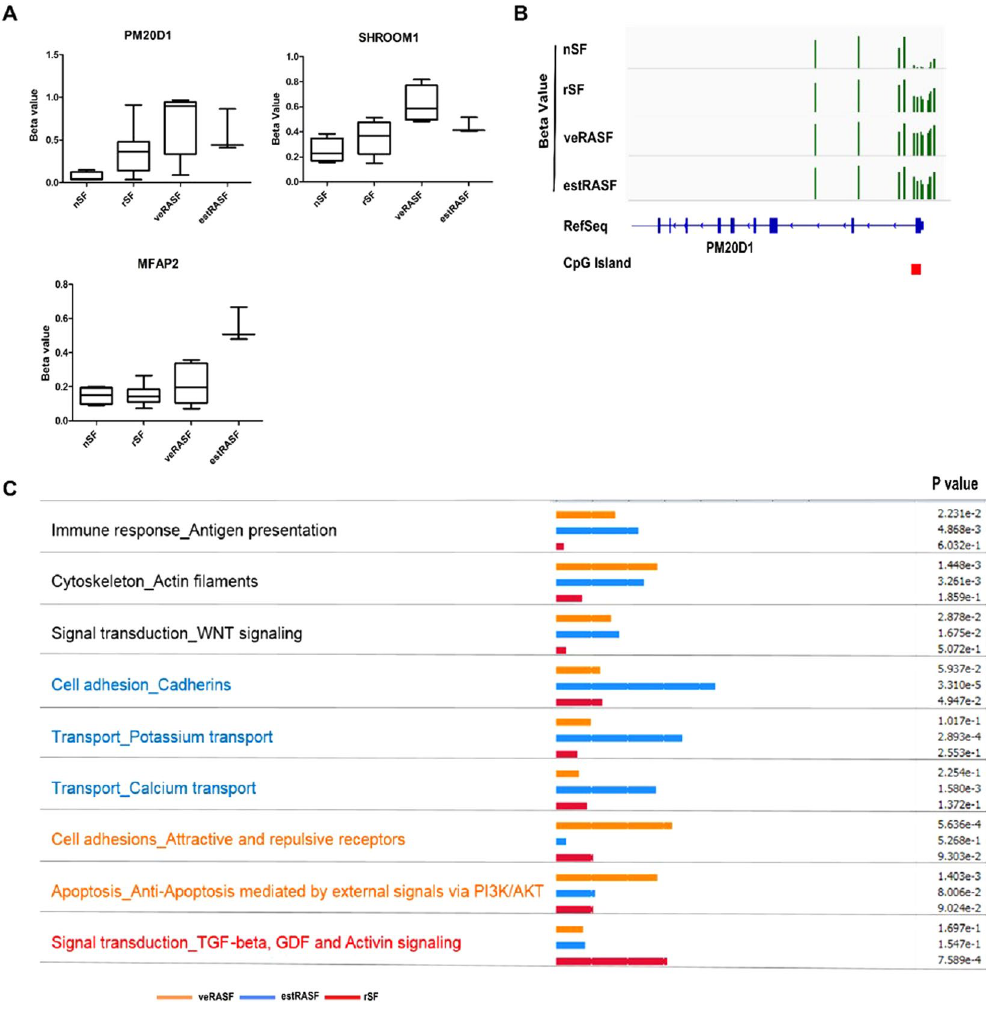
Figure 2. Hypermethylated genes and pathways between different disease stages. ( A ) An increase of the average beta values of PM20D1, MFAP2 and SHROOM1 occurred between nSF, rSF, veRASF and estRASF. The box plots show the media, minimum, maximum and quartiles of beta values. ( B) Hypermethylation was observed in the CpG Island within the PM20D1 promoter of rSF, veRASF and estRASF. The graph represents DNA methylation beta values for each sample aligned to the genomic reference and CpG Island of hg19 UCSC genomic assembly by IGV viewer software. ( C ) The top enriched pathways in significantly differential methylated sites (DMS) in very early RASF (veRASF), established RASF (estRASF) and resolving arthritis (rSF) respectively are